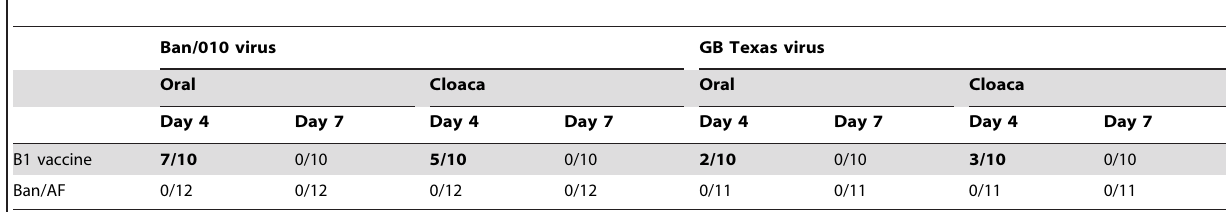
Table 7. Viral shedding of vaccinated 1-day old birds after